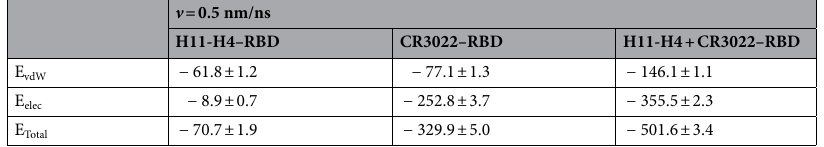
Table 3. Non-bonded interaction energies (kcal/mol) of the H11-H4–RBD, CR3022–RBD, and H11- H4 + CR3022–RBD complexes. The results were obtained for a [0- t max ] time window and averaged from five SMD trajectories performed at a pulling speed of v = 0.5 nm/ns. The errors represent standard deviations.